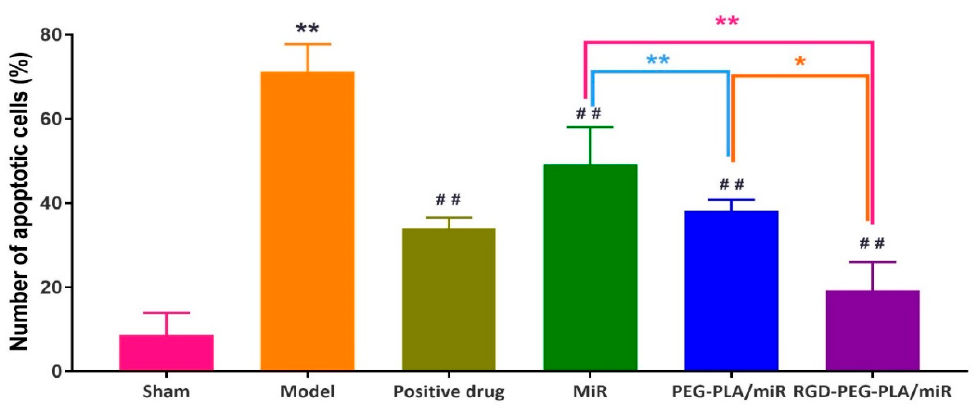
Figure 12. The number of apoptotic cardiomyocytes in six groups of rats (mean ± SD, n = 6). Compared with the sham group, the difference was statistically significant (** p < 0.01). Compared with the model group, the difference was statistically significant ( ## p < 0.01). The color asterisks indicate significant differences between the two groups, * p < 0.05 and ** p < 0.01.